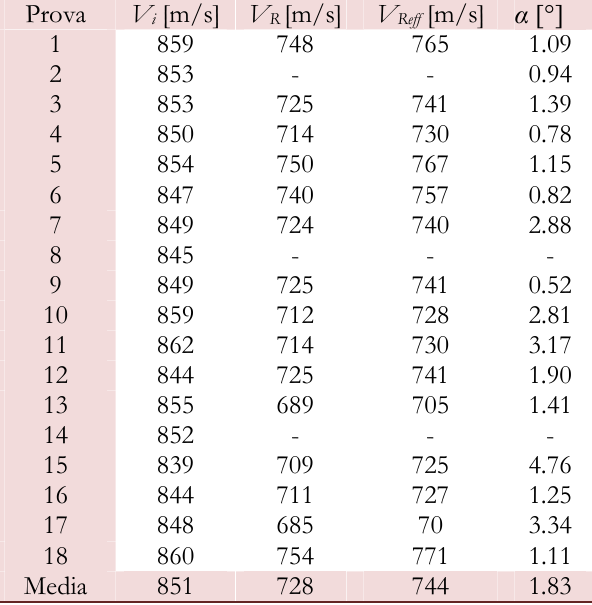
Tabella 4: Velocità iniziale del proiettile (V), velocità residua (V R ), velocità residua effettiva (V Reff )